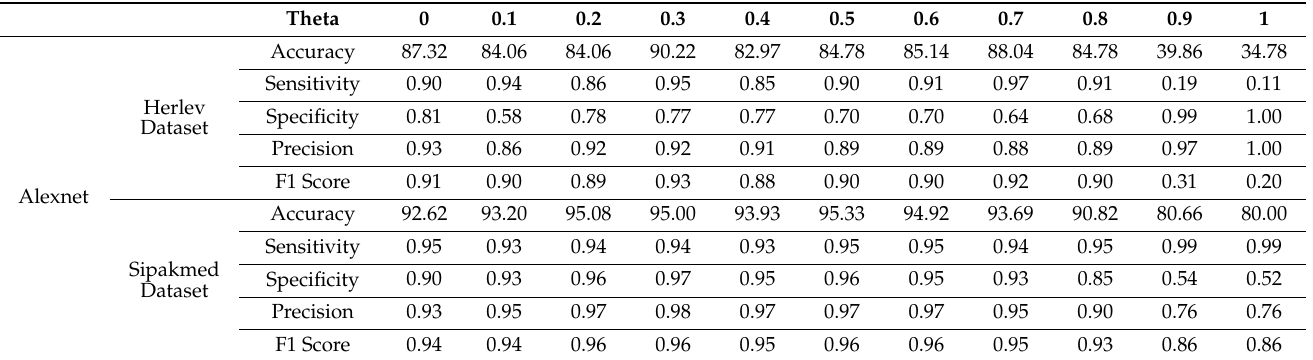
Performance Evaluation of Alexnet Pre-Trained Model with Fuzzy Min–Max Neural Network.